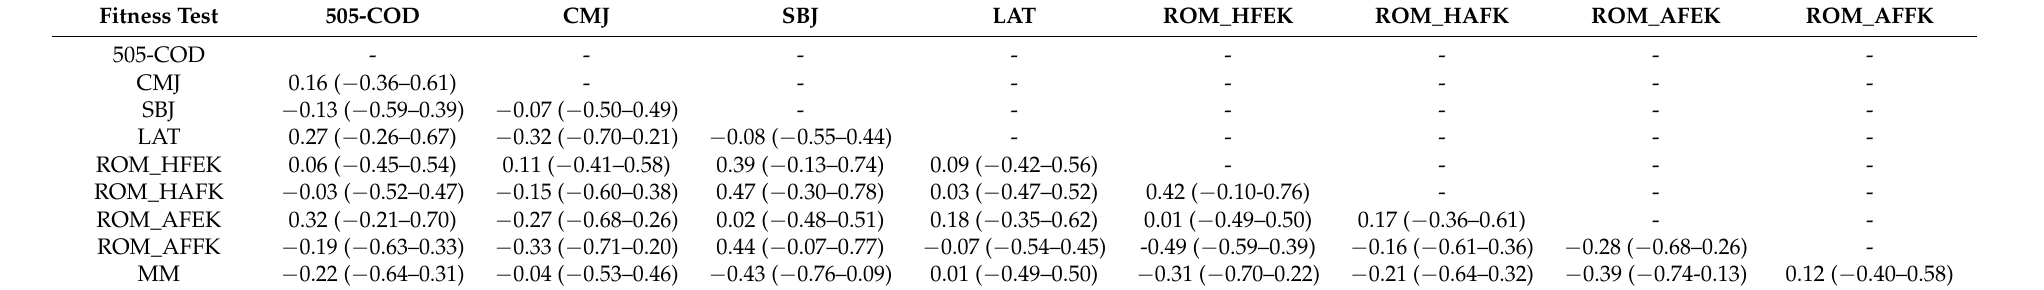
Table 3. Pearson r correlations (95% confidence intervals) between the different interlimb asymmetry